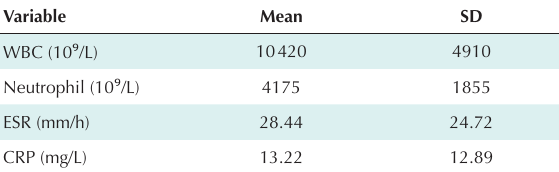
Table 2. Mean and SD of Patients’ Laboratory